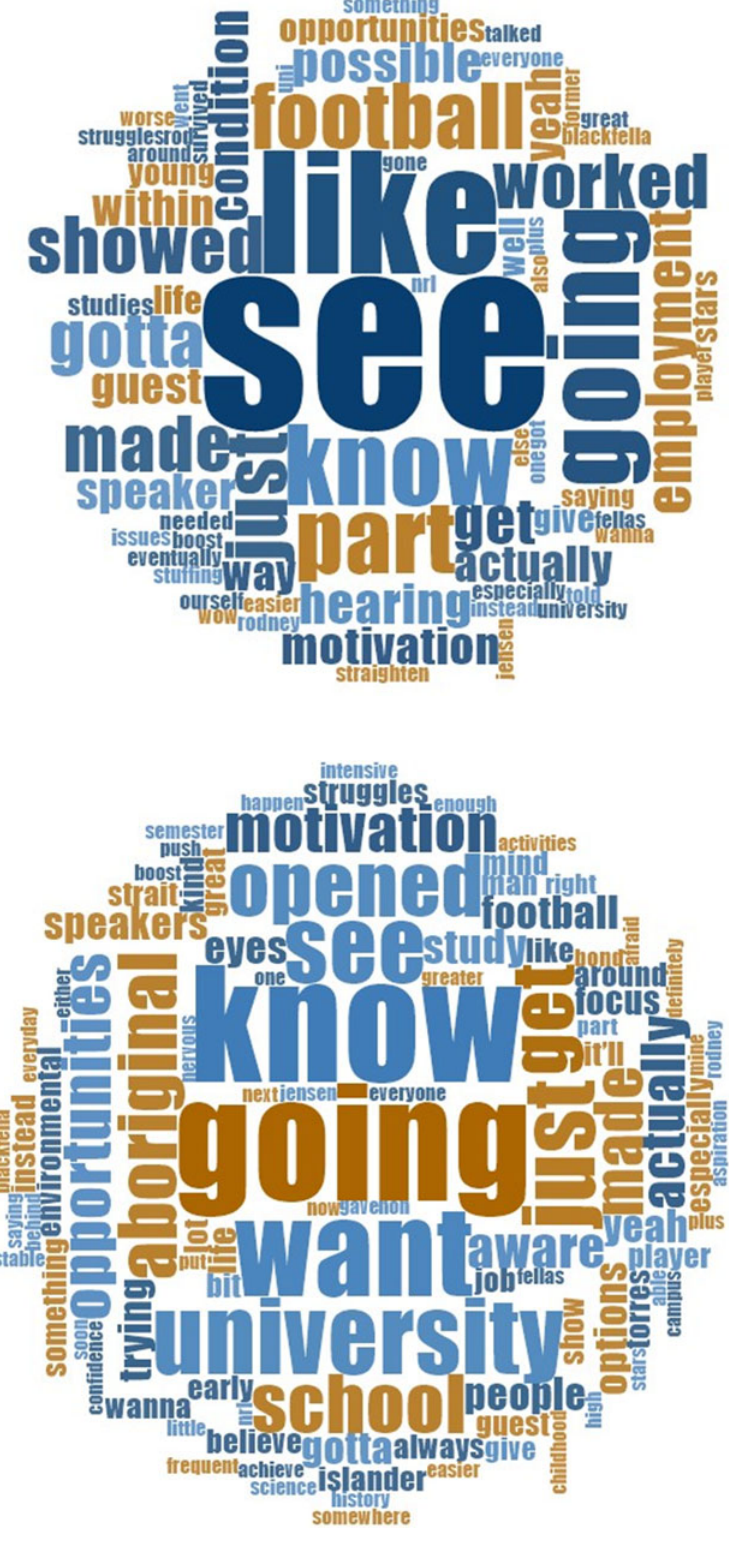
Fig. 4. Tag cloud of participants ’ perceptions of the impact of Burunga M Gambay on their plans and aspirations for their future